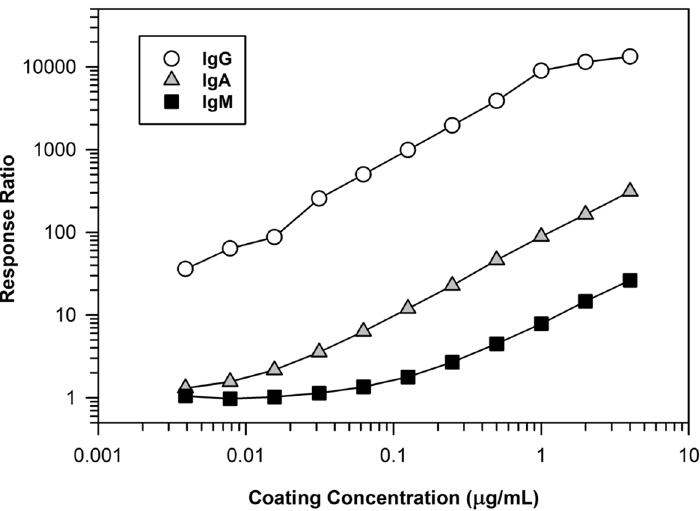
Figure 1. Detection of different human immunoglobulin classes by SULFO-TAG Protein-A/G. A MSD plate was coated with varying concentrations of human IgG, IgM, or IgA diluted in PBS and incubated it overnight at 4 °C. On the following day, the plate was washed and blocked with PBS-2% BSA. After another wash, the coated immunoglobulins were detected using 0.2 µg/mL SULFO-TAG labeled Protein-A/G diluted in PBS-2% BSA. The plot shows the ratio of the relative luminescence (RLU) signal responses for coated wells relative to uncoated wells.